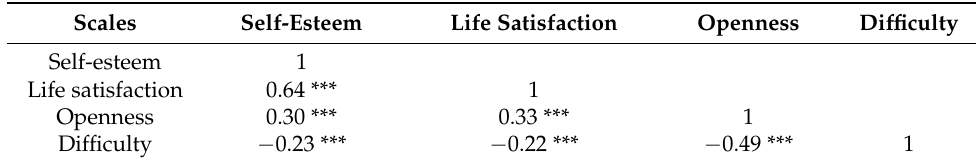
Table 2. Pearson correlation coefficients between self-esteem, life satisfaction, and both dimensions of peer communication ( N = 429). Scales Self-Esteem Life Satisfaction Openness Difficulty Self-esteem 1 Life satisfaction 0.64 *** 1 Openness 0.30 *** 0.33 *** 1 Difficulty − 0.23 *** − 0.22 *** − 0.49 *** 1 *** p < 0.001.